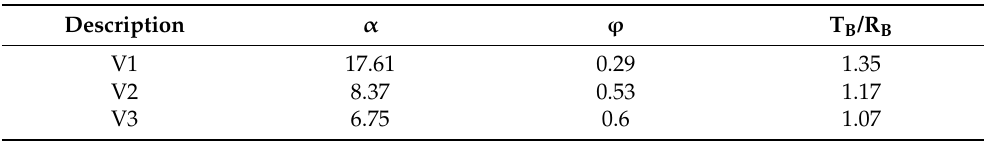
Table 4. The fitting parameters α and ϕ extracted from the QPC model fit for HRS curves and the determined ratios of T B /R B